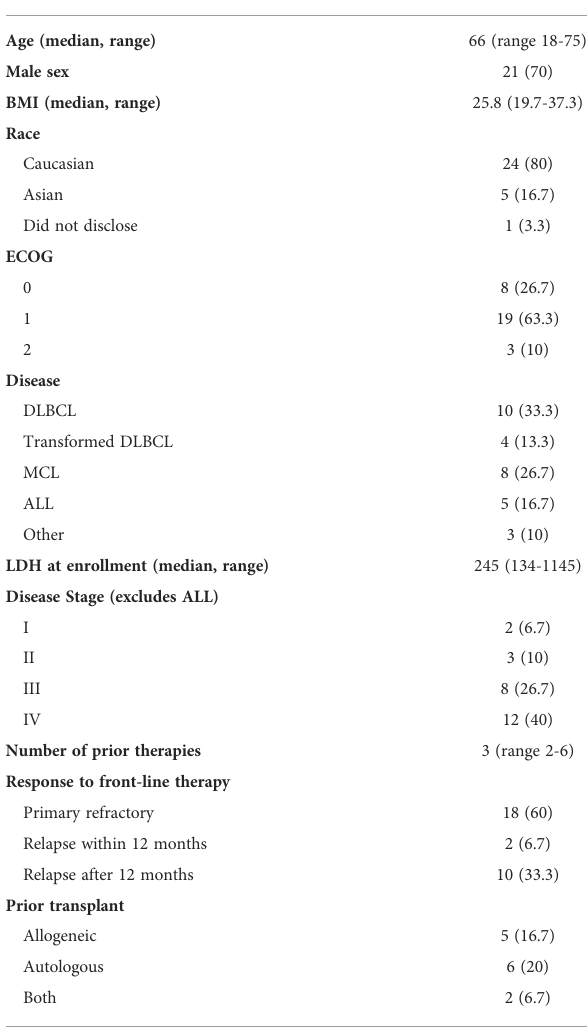
TABLE 1 Patient Characteristics for N=30